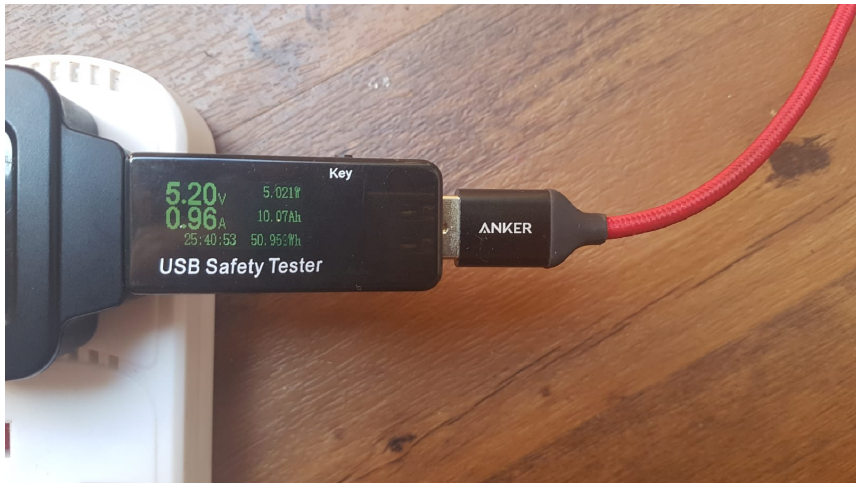
Figure 5. The Muker USB multimeter which was used to measure the energy consumption of running MLs algorithms on the Raspberry Pi